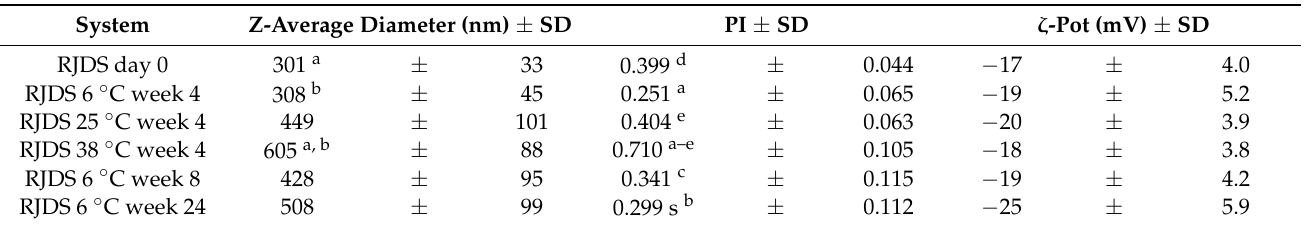
Table 3. Hydrodynamic diameter, polydispersity index and ζ -potential of the system at day 1 and after 1 month at various temperatures.